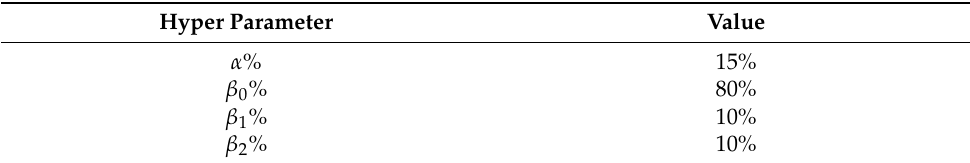
Table 2. Parameters during multi-level noise addition